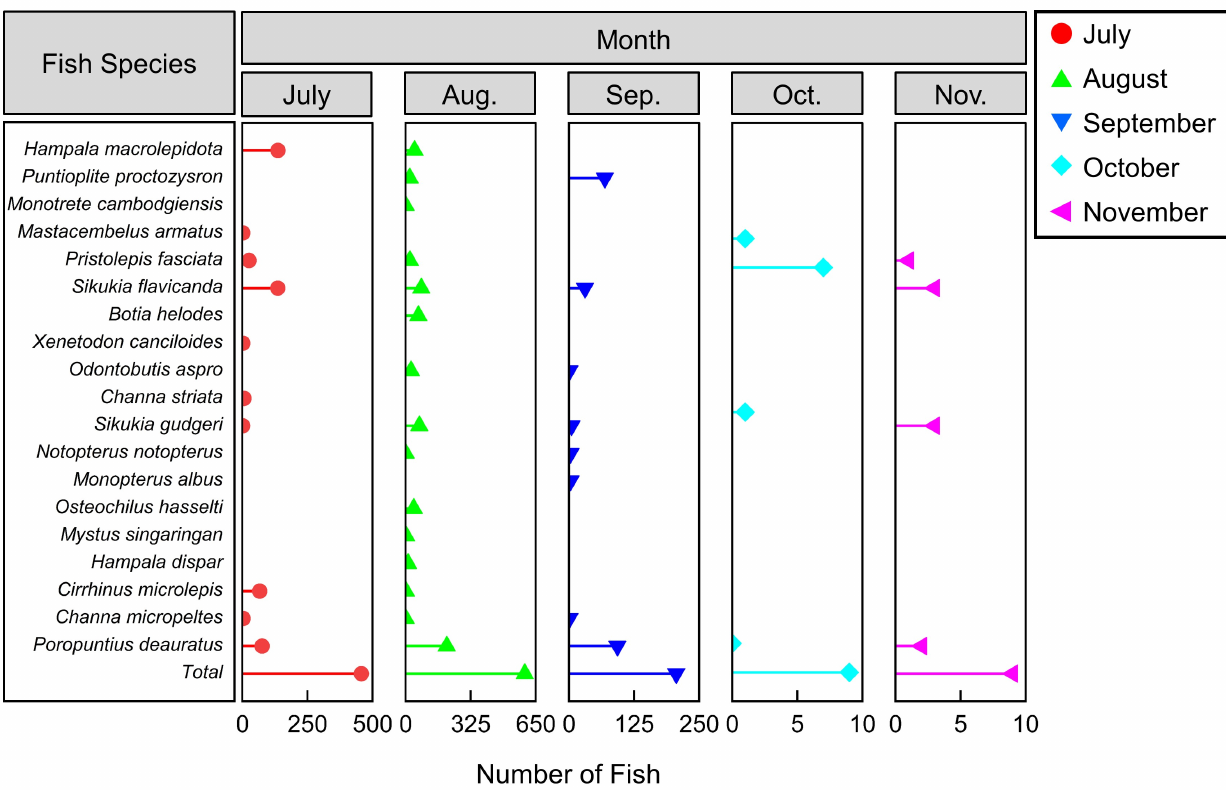
Figure 5. Difference in fish species and numbers from July to November in the NLP. More species ( N = 16) and number of fish ( N = 595) were found using the NLP to ascend in August compared with other months, followed by 457 ascending fish be- longing to 10 species found in July and 206 ascending fish (eight species) in September. However, nearly no fish chose to reach the upstream reservoir in October and November. The ascending species with proportions >10% in August included Poropuntius deauratus ( N = 206, 34.62%), Sikukia flavicanda ( N = 79, 13.28%), Sikukia gudgeri ( N = 69, 11.60%), and Botia helodes ( N = 64, 10.76%), with those in July including Hampala macrolepidota ( N = 137, 29.98%), Sikukia flavicanda ( N = 136, 29.76%), Poropuntius deauratus ( N = 76, 16.63%), and Cirrhinus microlepis ( N = 67,